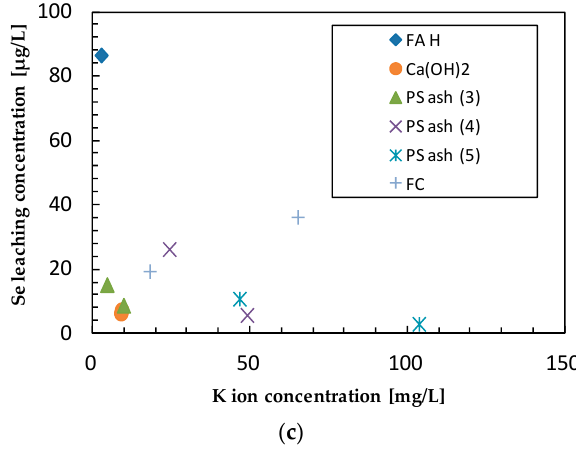
Figure A1. Relationship between the K ion leaching concentration and trace elements leaching concentration of five kinds of additives: ( a ) arsenic; ( b ) boron; and ( c ) selenium.